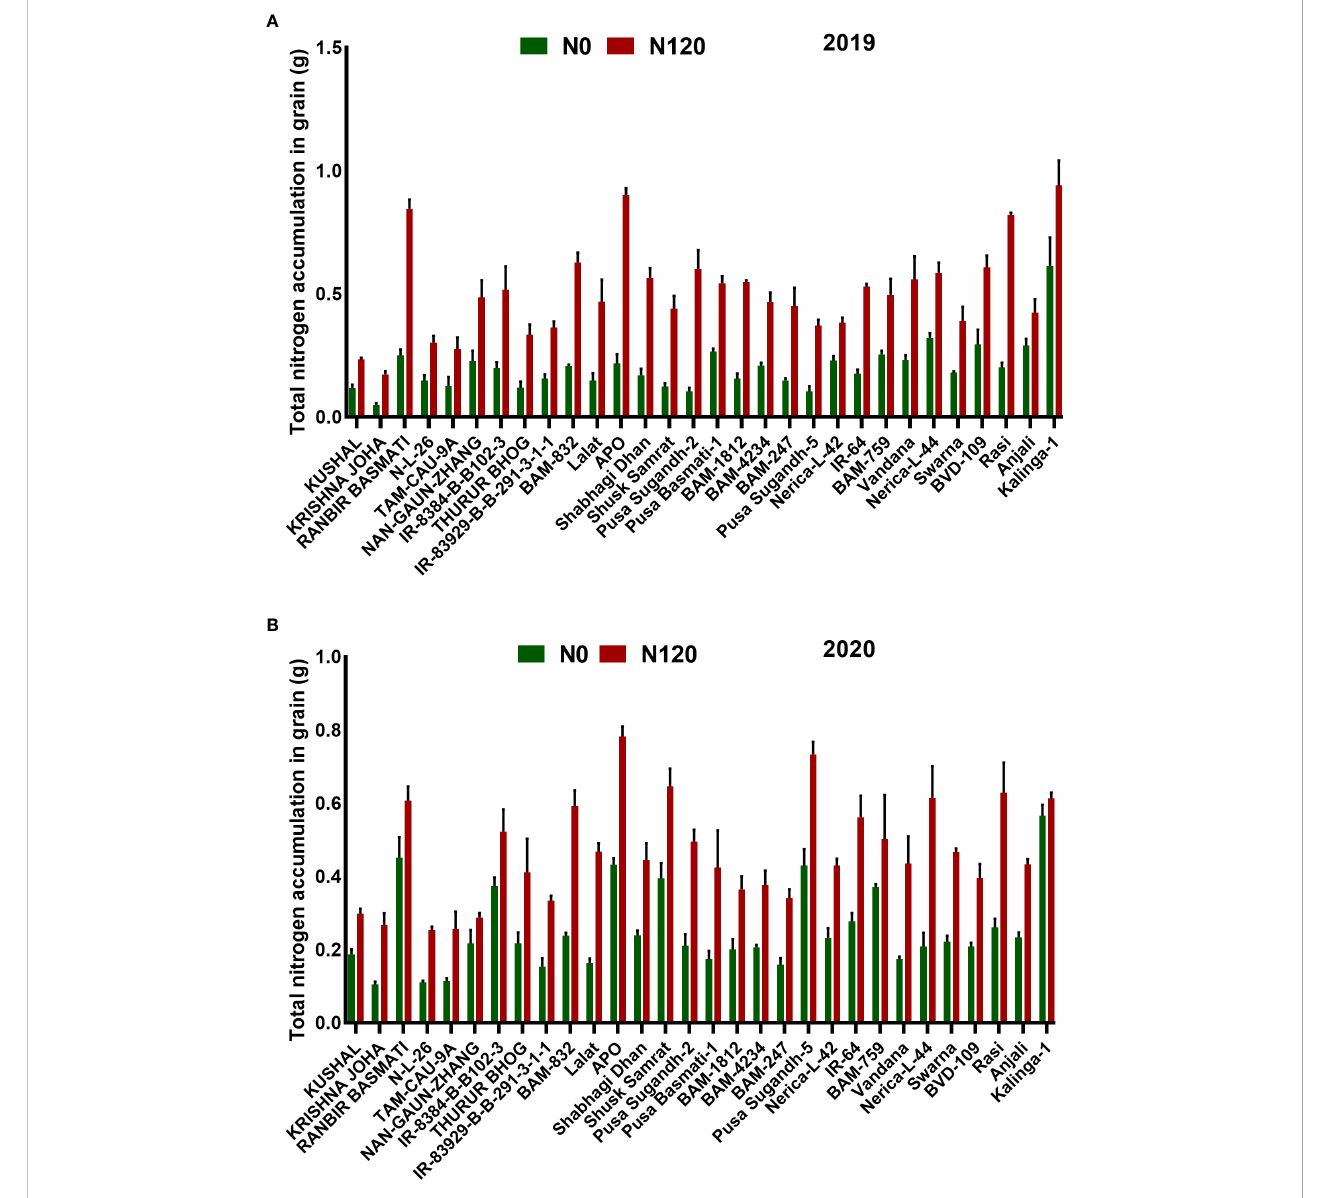
FIGURE 8 Effect of nitrogen de fi cient (0 kg ha-1 fertilizer N: N0) and nitrogen suf fi cient (120 kg ha-1 fertilizer N: N120) fi eld conditions on total nitrogen accumulation in grain during (A) the 2019-kharif and during (B) the 2020-kharif cropping seasons in diverse rice genotypes. Values presented are Mean ±SE with three